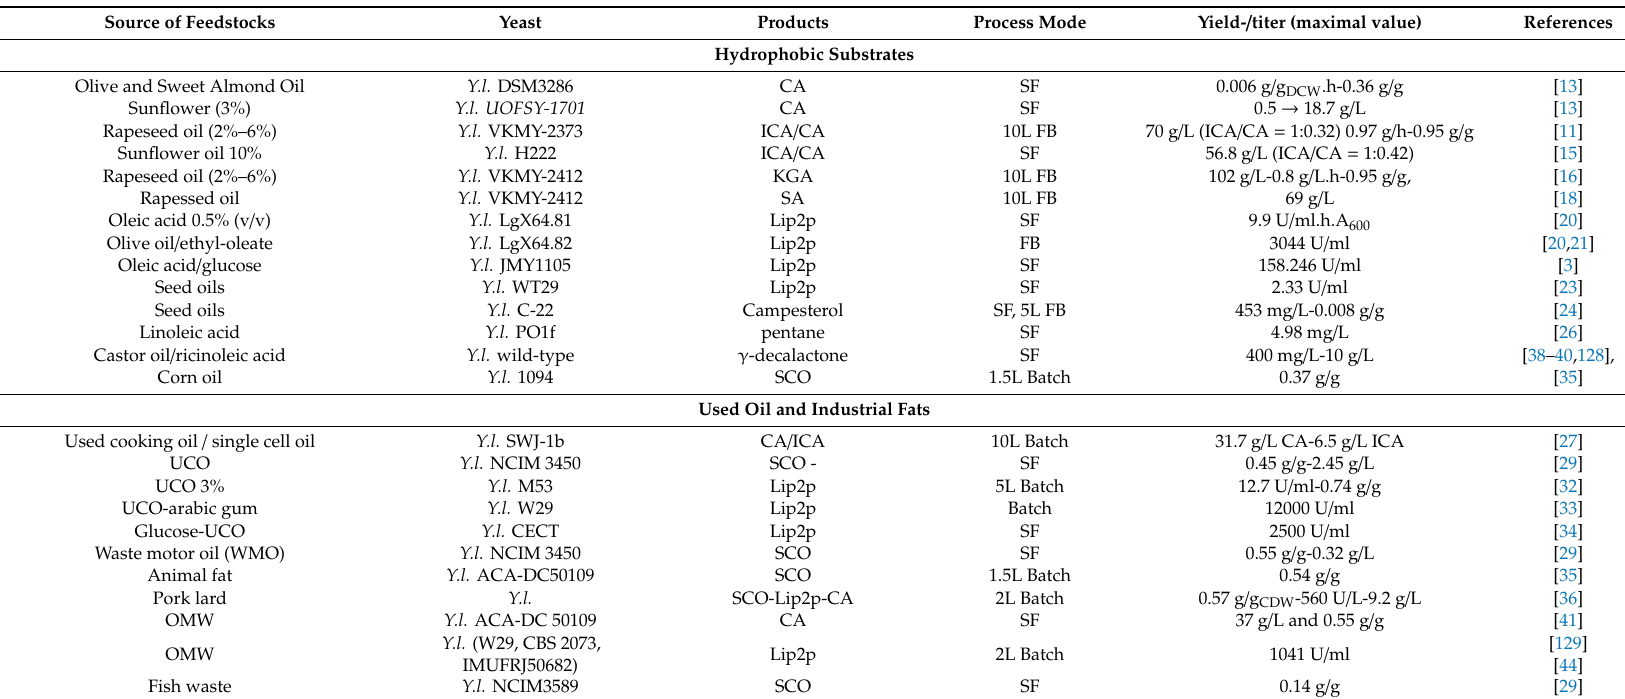
Table 1. Summary of feedstocks used for production of metabolites or rProt by non-conventional yeasts. Y.l.: Y. lipolytica ; P.p.: Pichia pastoris ; O.p.: Ogatea polymorpha ; P.g.: Pichia guilliermondii ; R.m.: Rhodotorula mucilaginosa; P.a. : Pichia anomala; P.v .: Pichia veronae; P.s .: Pichia stipitis ; P.k.: Pichia kudriavzevii; K.m.: Kluyveromyces marxianus. CA: citric acid; ICA: isocitric acid; KGA: α -ketoglutaric acid; PYR: pyruvate, SA: succinic acid; Lip2p: extracellular lipase Lip2p; SCO: single cell oil /